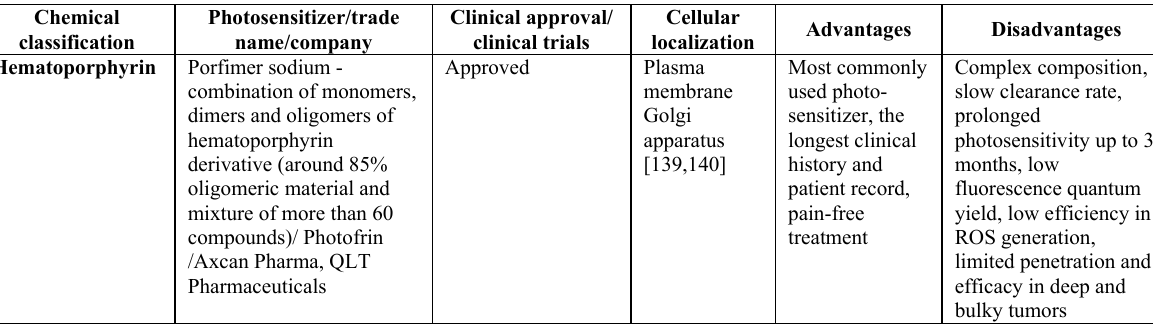
Table 1. Properties of selected